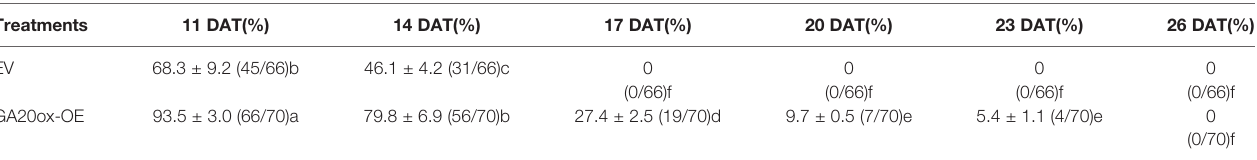
Fruitretentionratevaluesaremeansofthreelocations(±SD).Dataaremeansof60 – 70 fl owers.Valuesinparenthesesrepresentthenumberofretentivefruitoverthetotalnumberoffruits. Values followed by a different letter are statistically signi fi cant at P < 0.05 (Duncan's range test). EV, empty vector; GA20ox-OE, GA20ox overexpression; DAT, days after